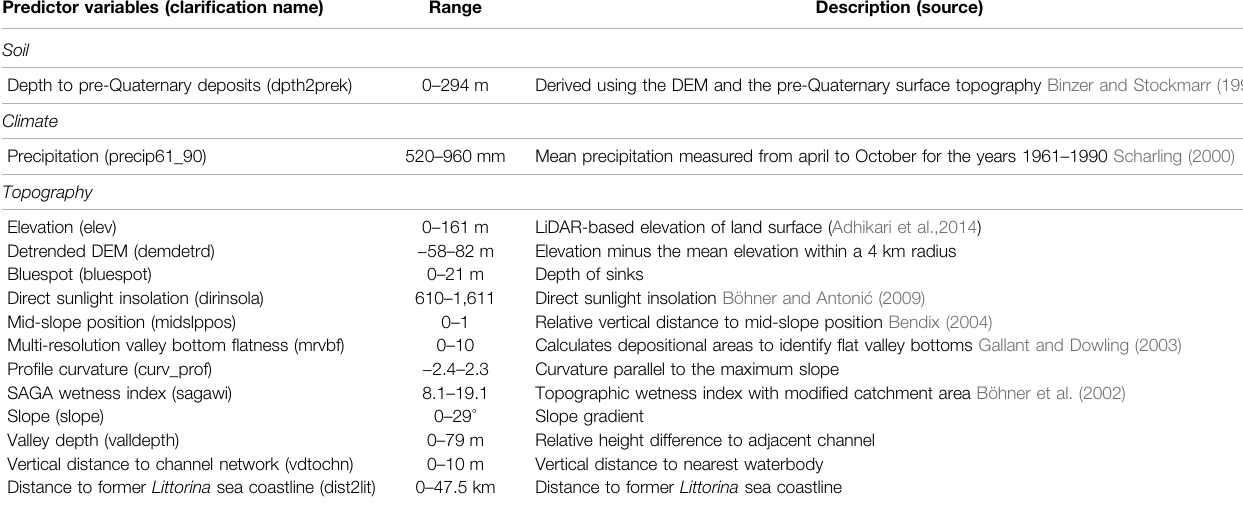
TABLE 1 | Environmental covariates selected for the